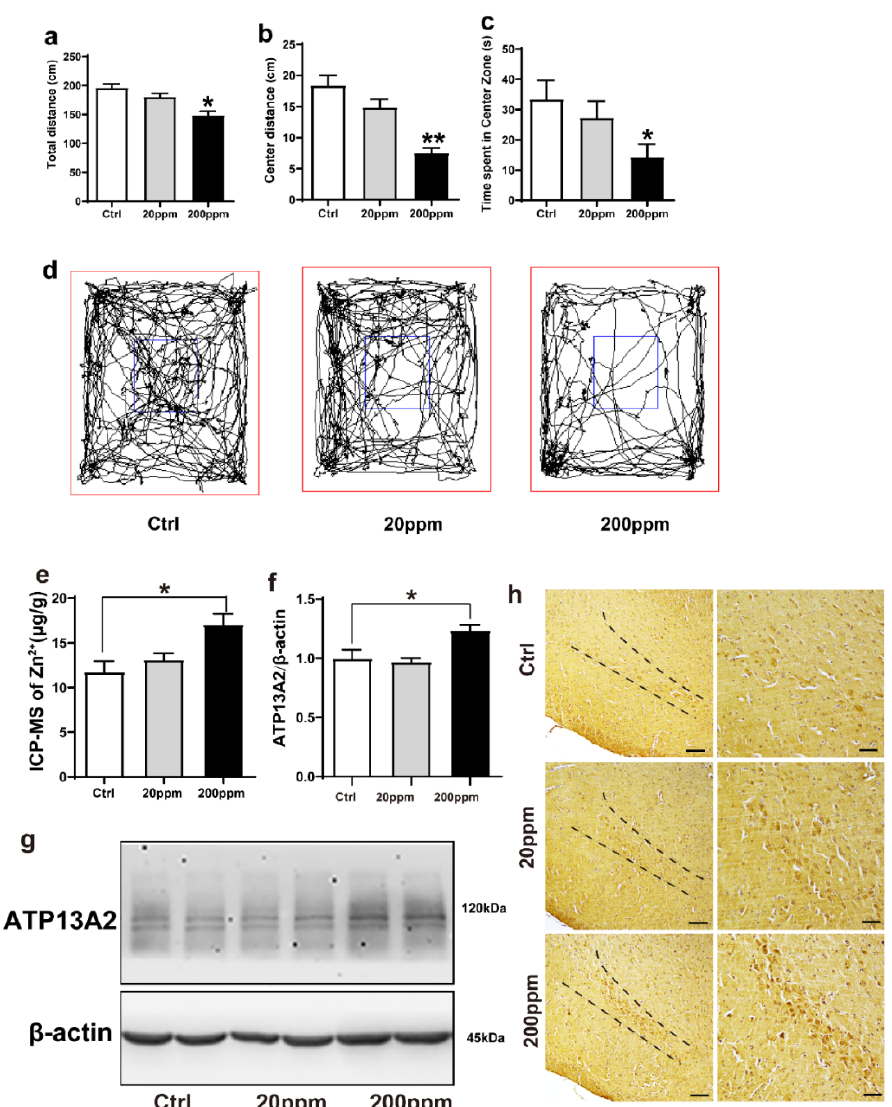
Figure 1. Zn 2+ treatment reduces spatial exploration behavior and increases the expression levels of ATP13A2 protein in the brains of mice. The nine-month-old α -synuclein-GFP mouse models were treated with different doses of ZnSO 4 (20 or 200 ppm) for three months. ( a ) Total distance traveled in open field exploration in 5 min. ( b ) Movement distance in zone center showing 5 min of open field exploration by the mice. ( c ) Time spent in the center zone showing 5 min of open field exploration by the mice. ( d ) Five minutes movement tracks of open field exploration by the mice. (( a – d ), n = 10 mice per group) ( e ) Zinc levels in the brain tissue were determined using ICP-MS (( e ), n = 6 mice per group), and expression of the ATP13A2 ( g ), representative pictures; ( f ), quantification; n = 6 mice per group) was analyzed using immunoblotting. ( h ) ATP13A2 positive reaction was detected in substantia nigra pars compacta cells via immunohistochemistry using ATP13A2 antibody (scale bar = 50 μ m) (( h ), n = 6 mice per group). Data are represented as the means ± SEM. The maximum and minimum values were removed from each group. Compared with the control group * p < 0.05, ** p < 0.01.